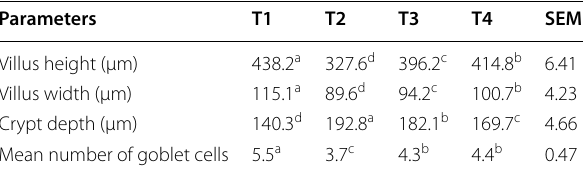
Table 5 Morphometric analysis of the ileum under different treatment conditions